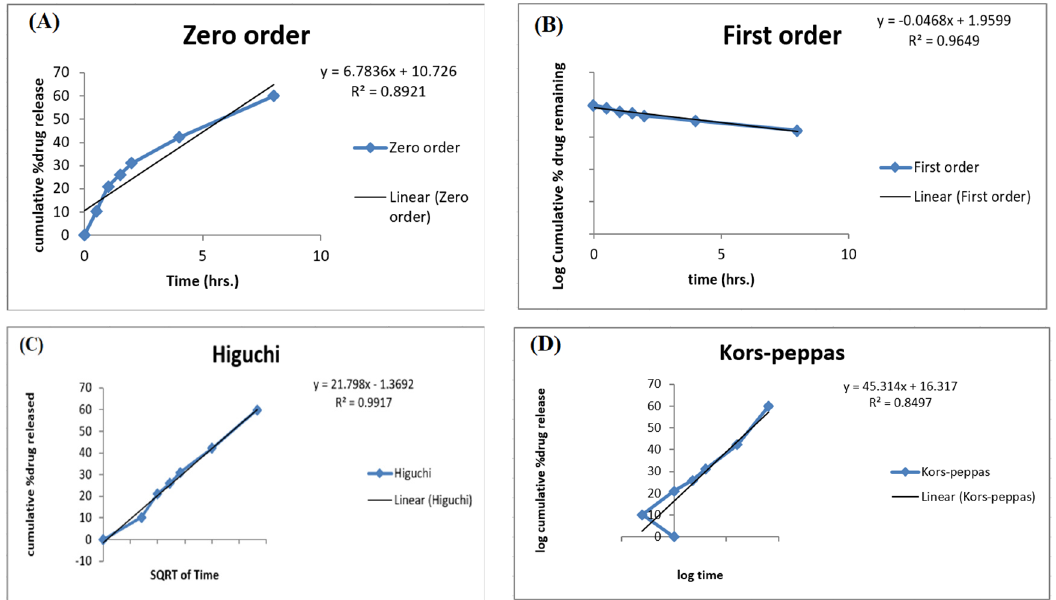
Figure 9. Different release kinetic models for optimized ACR-PCL-NPs. ( A ) zero-order, ( B ) first-order, ( C ) the Higuchi model, ( D ) the Korsmeyer-Peppas.